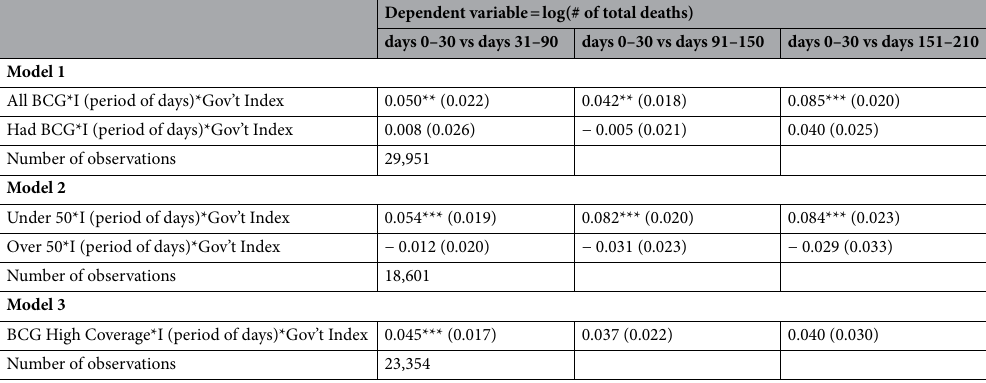
Table 2. Summary of effects of BCG interacted with government response index. ***p < 0.01, **p < 0.05. Standard errors are clustered at country